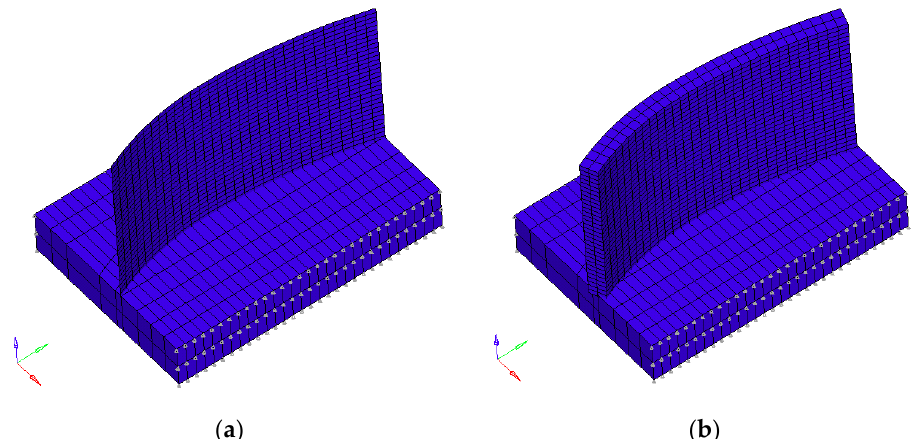
Figure 5. ( a ) Traditional shell element representation, ( b ) 3D element representation, showing the